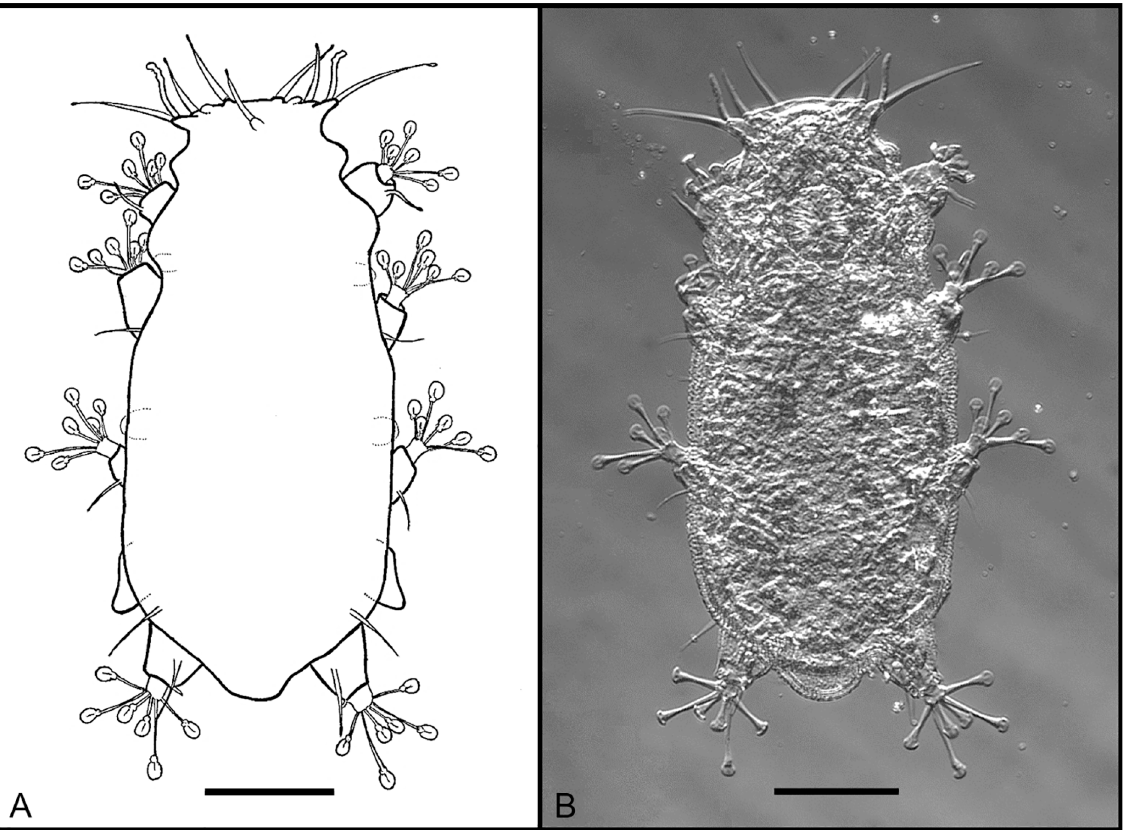
Fig. 4. Batillipes lusitanus sp. nov. A . Schematic drawing, dorsal view. B . Habitus of the holotype, ♀, ventral view. Scale bars = 50